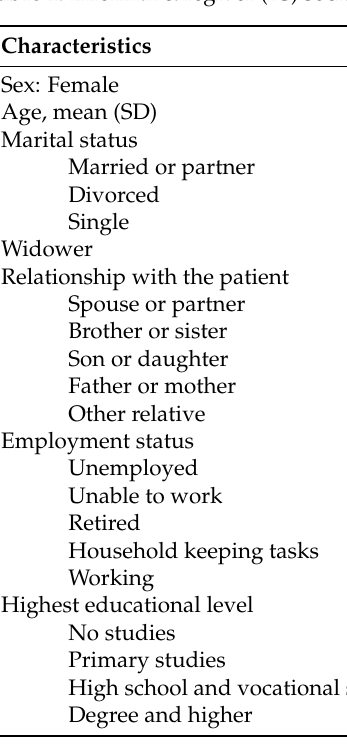
Figure 1. Flow chart of the inclusion process. Table 1. Informal caregiver (IC) sociodemographic characteristics.